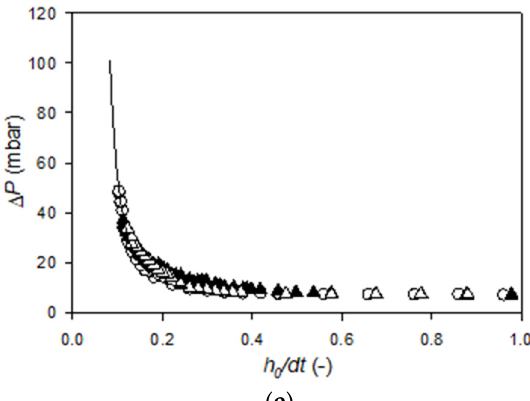
Figure A1. Profiles of measured FDG pressure drop vs relative distance, h 0 / dt , for fouling experiments with low surface charge PS–PAA microparticles with ( a – c ) and without ( d , e ) calcium ions. Figure A2 shows profiles of FDG pressure drop vs. relative distance for FDG scans from filtration experiments with high surface charge microparticles with and without Ca 2+ . As in Figure A1, scans of clean membrane, fouled membrane and as well as post-fouling removal scans are shown.